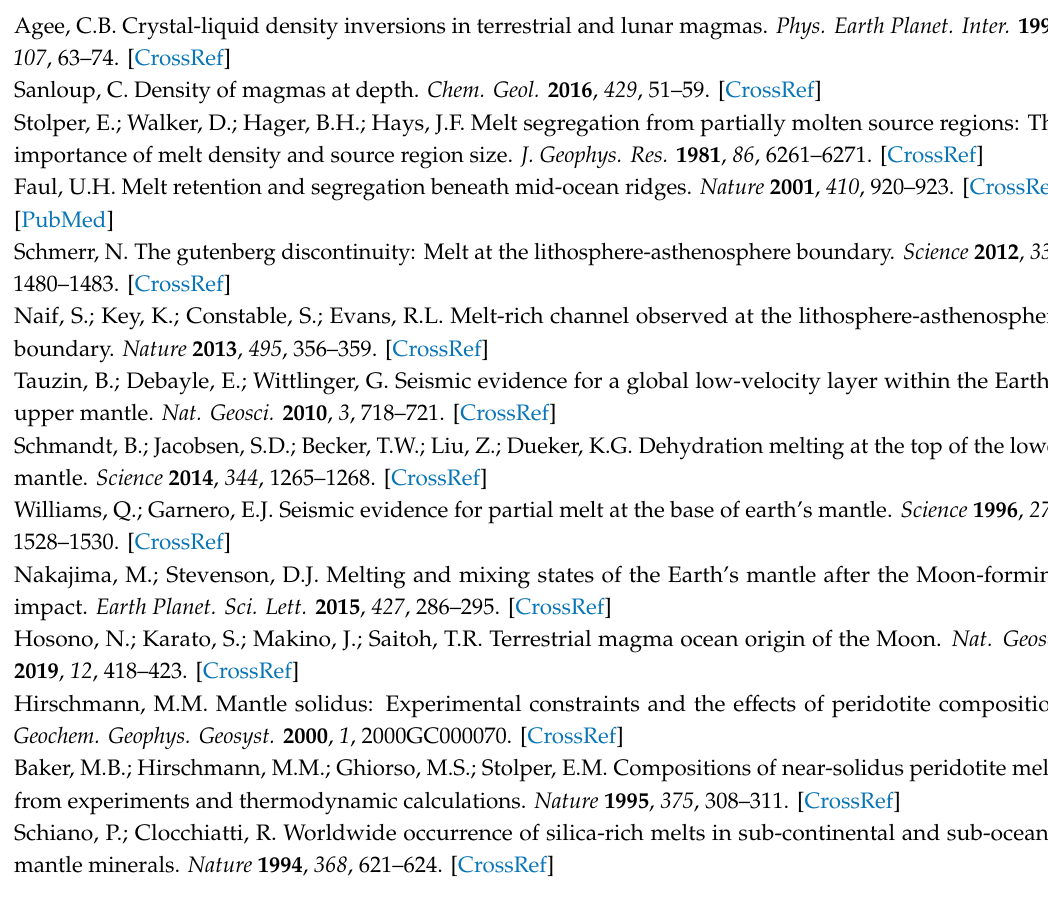
Figure S1: Temperature-power relationships calibrated at di ff erent loads for the PE cell assembly used for tomographic measurements on silicate melts, Figure S2: SEM images and EDS composition mapping of the quenched sample, Figure S3: Correlations between fitted K 0 and K ’, Table S1: Compositions of the quenched sample measured by